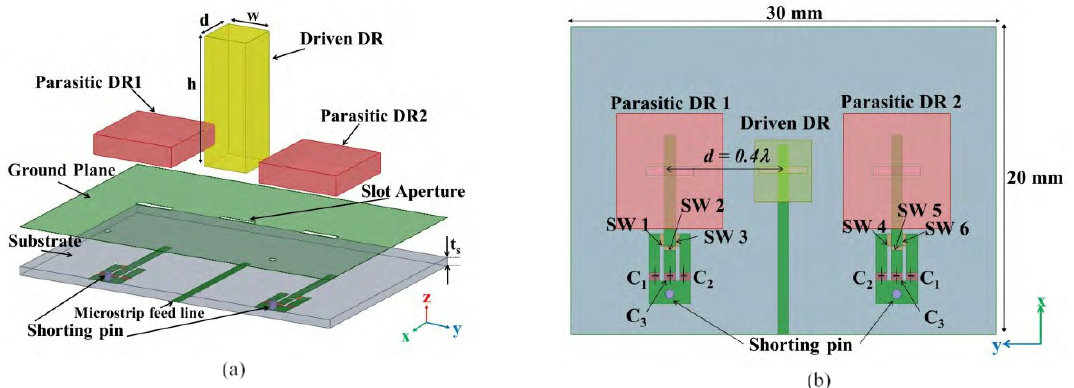
Figure 16. The geometrical configuration of the proposed DRA array. ( a ) 3D view. ( b ) Top view [62].